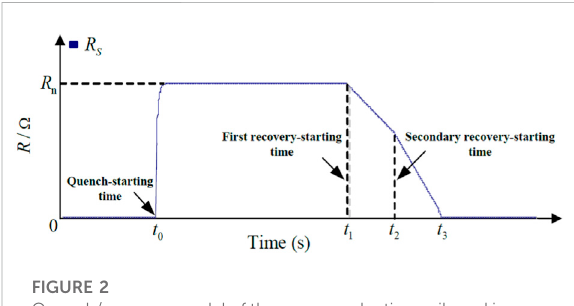
Figure 1. As mentioned before, the lower plot is a normalized performance of the voltage across R sc as a function of the ratio of the current through the SFCL device ( I Line )to the critical current ( I c ) of the superconducting element . The level of the current at which the quench happens is identi fi ed by the operating temperature, the size, and the category of the superconductor. The quick rise in resistance produces a voltage across the superconductor and leads the current to convey to a shunt, a combination of resistor and inductor. The shunt ’ s role is to limit the voltage increase across the superconductor in the quench situation. In essence, the superconductor works like a switch with a millisecond response that stimulates the transition of the load current to the shunt impedance. Theoretically, the initial fault current is restricted to less than one cycle [Electric Power Research Institute (EPRI), 2009].